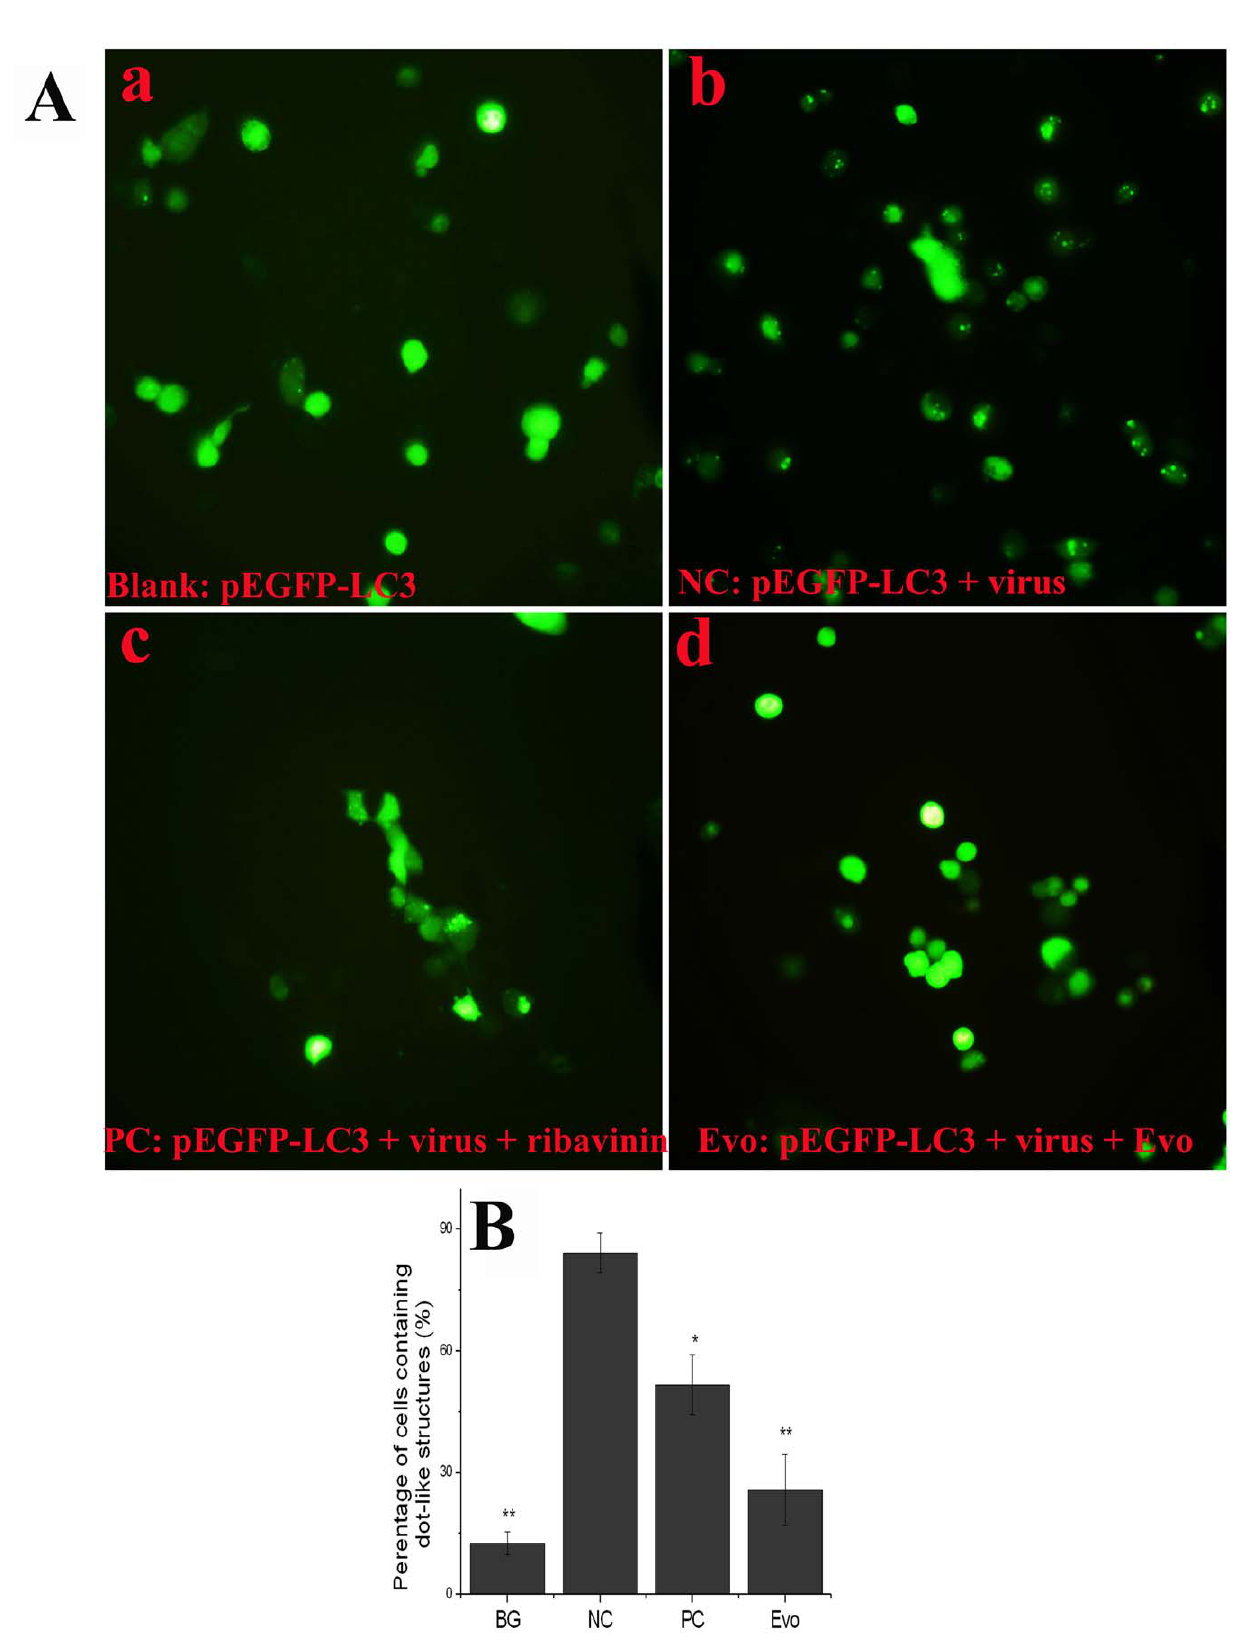
Figure 6. Evodiamine inhibits the IAV-induced autophagy determined by EGFP-LC3 assay. ( A ) Evodiamine inhibits the dot-like aggregation of EGFP-LC3 onto autophagosomes. ( B ) The percentage of cells containing EGFP-LC3 dots to cells expressing EGFP. After transfection